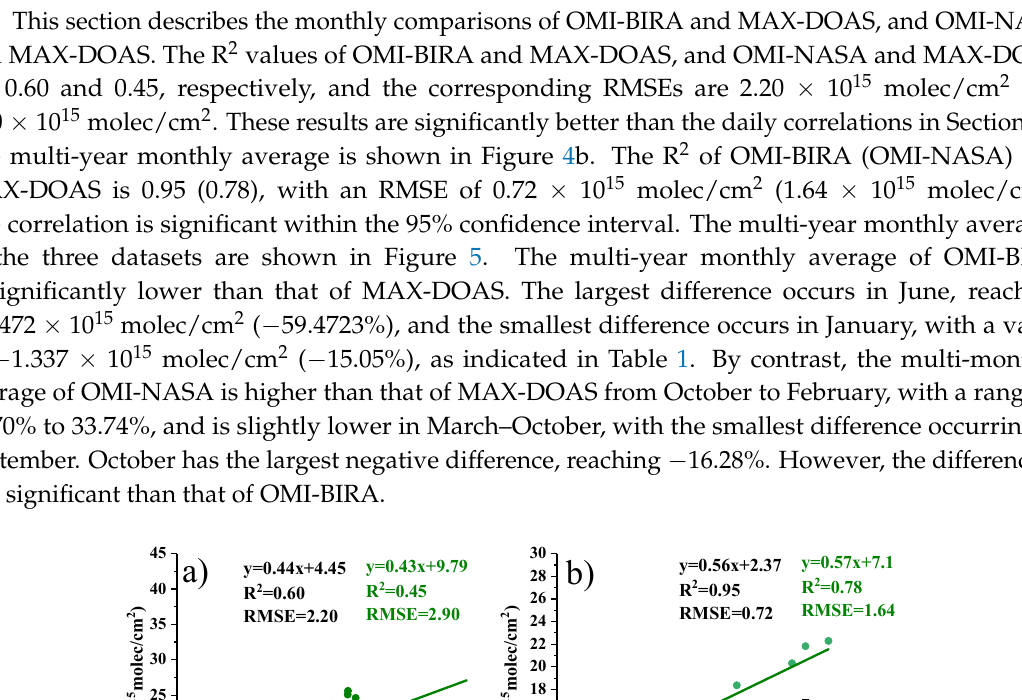
Figure 5. Multi-year monthly averaged HCHO concentrations for OMI-BIRA, MAX-DOAS and OMI-NASA. Table 1. Absolute and relative differences between OMI-BIRA, OMI-NASA and MAX-DOAS based on multi-year averages.